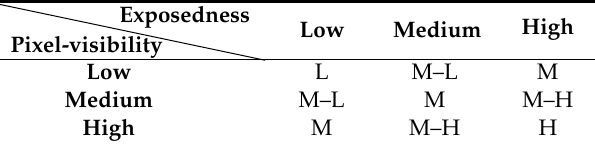
Table 1. Fuzzy rule base of fusion weight